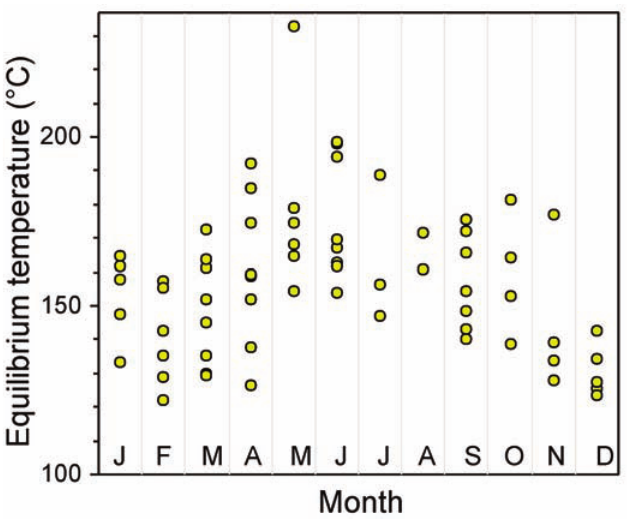
Figure 8. Equilibrium temperature of the Pisciarelli fumarole versus the month of sampling. Maximum estimated values characterize the spring and summer samples, indicating strong seasonal